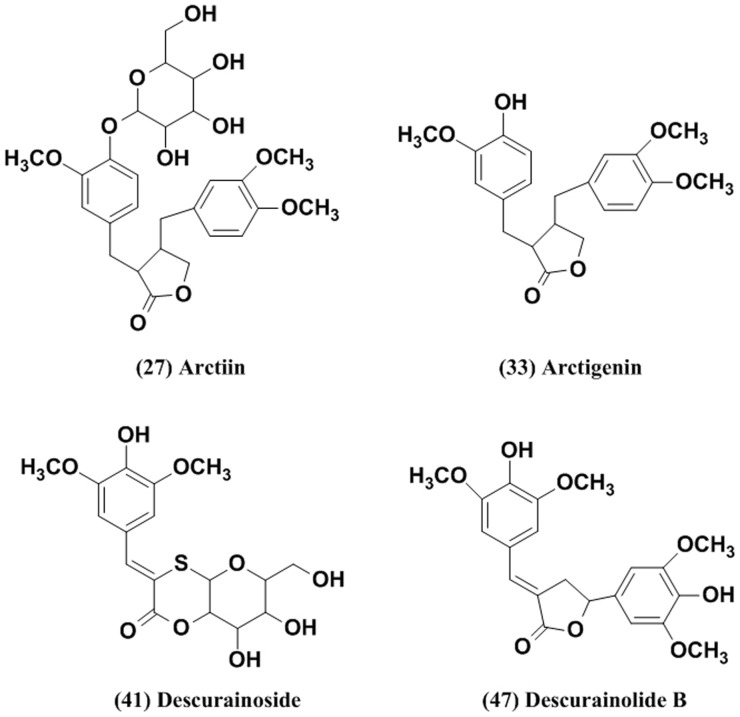
Structures of the QFXY constituents exhibiting a synergic effect on the β2AR-signalling pathway.